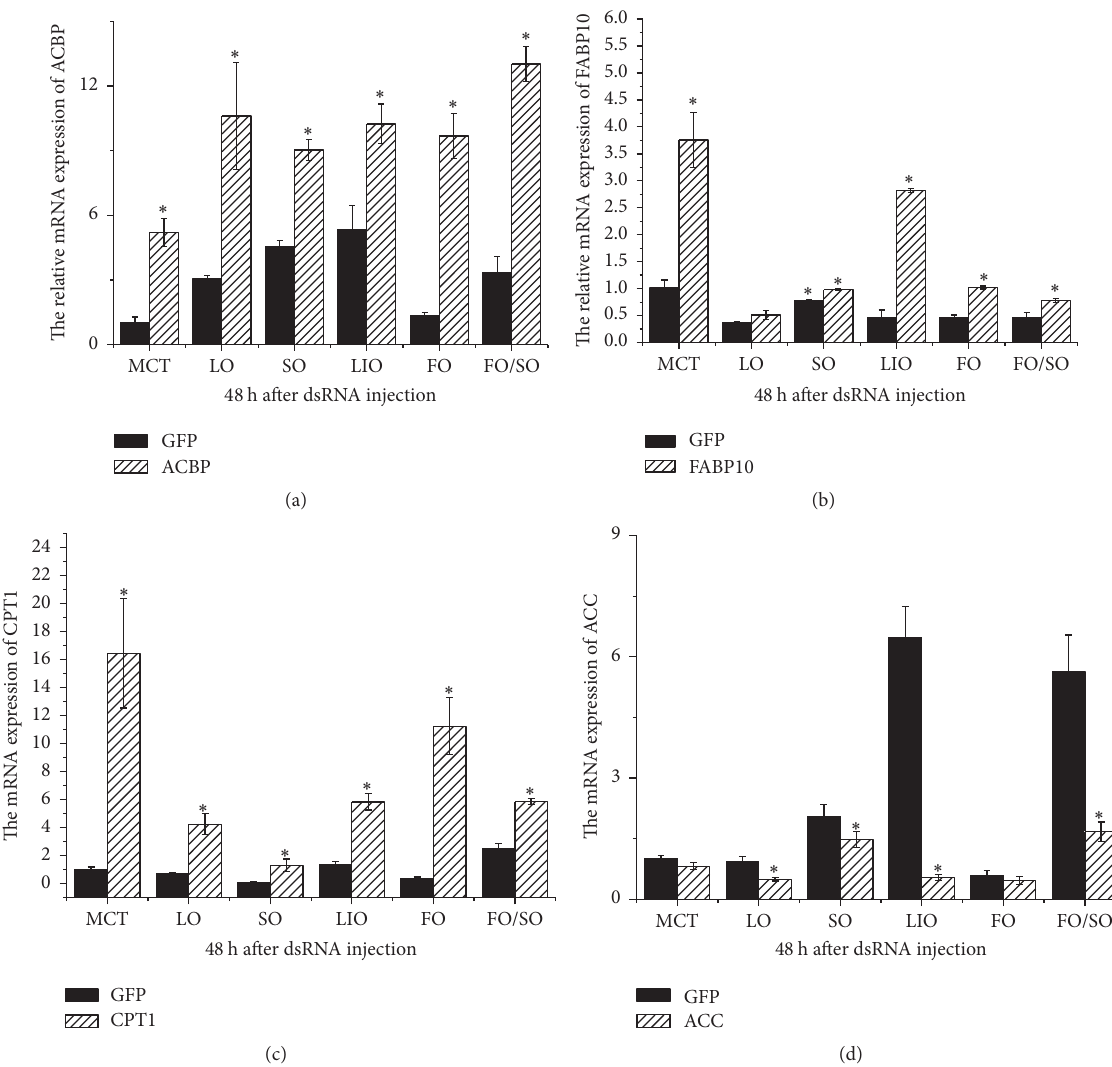
Figure 7: Real-time quantitative PCR analysis of ACBP (a), FABP10 (b), CPT1 (c), and ACC (d) transcript expressions in the hepatopancreas of M. nipponense injected with either MnSR-BI or GFP dsRNA at 48 h. Bars indicate mean ± SD ( 𝑛 = 3 ). ∗ 𝑃 < 0.05